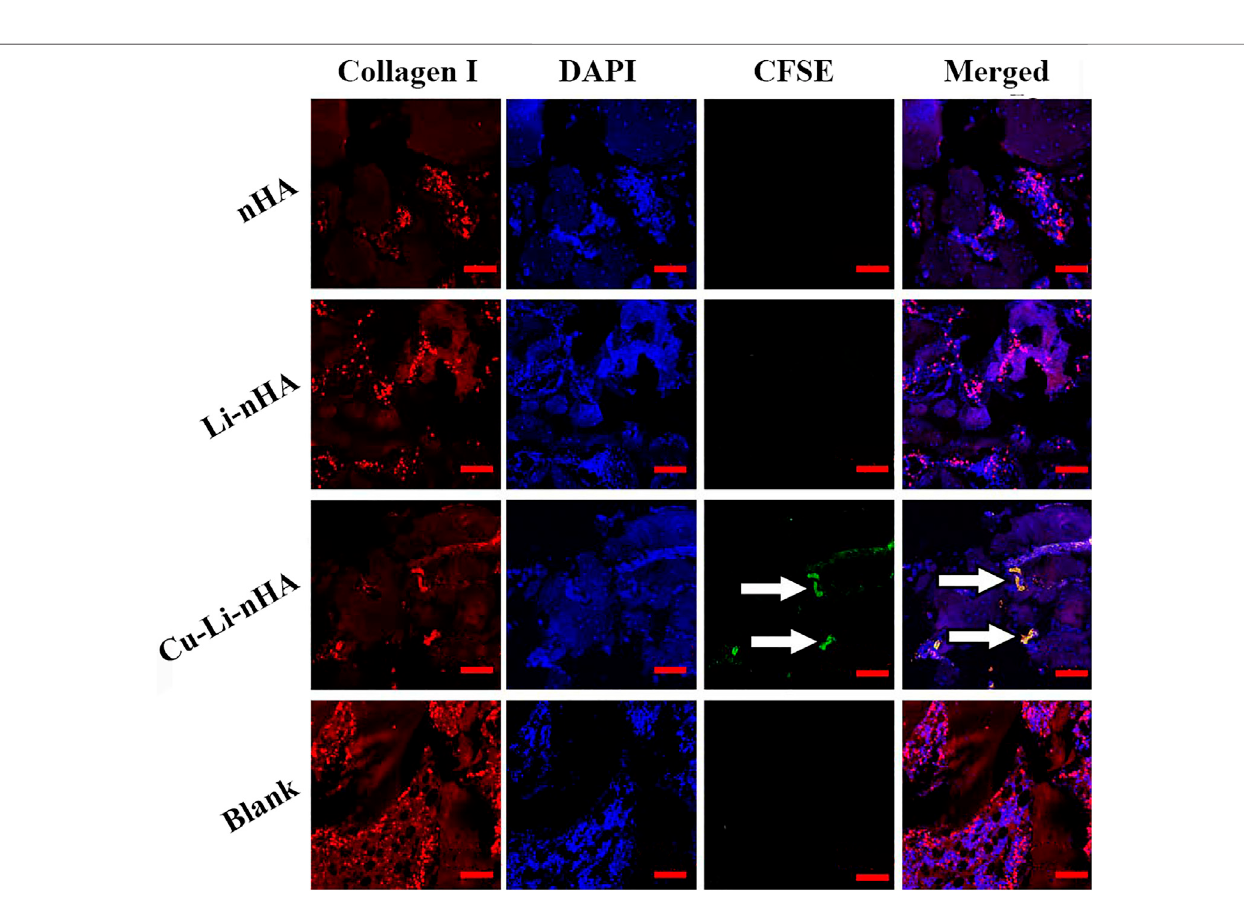
conducted with diluted primary antibodies (1:200) at 4 ° C overnight and visualized with a secondary antibody.